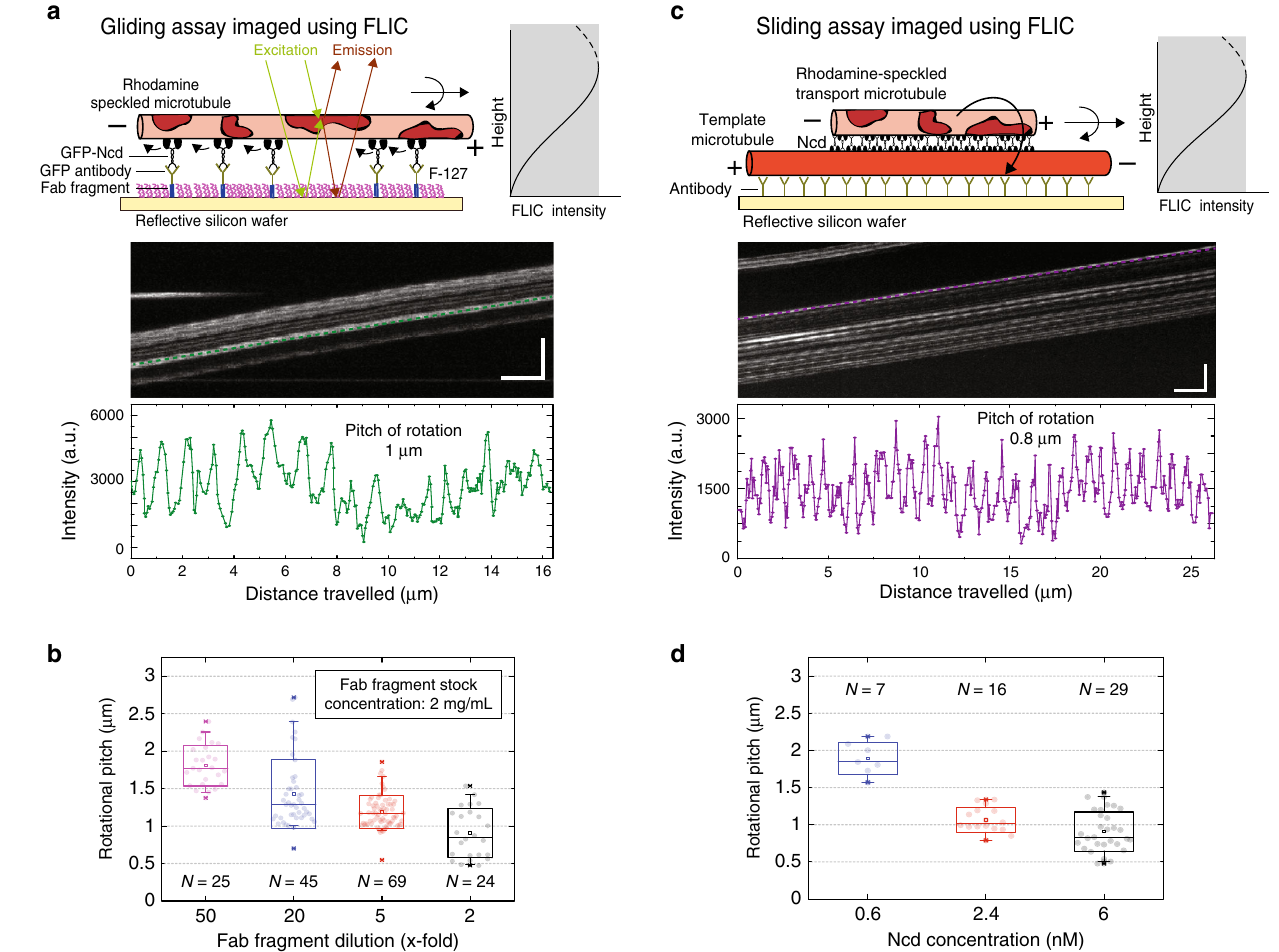
Fig. 4 Dependence of rotational pitch of microtubules on Ncd motor density. a Measurement of the rotational pitch of speckled microtubules gliding on a re fl ective silicon substrate coated with GFP-Ncd via anti-GFP antibodies bound to Fab fragments. Due to fl uorescence interference contrast (FLIC), the recorded intensities of the asymmetric speckles change as a function of height above the substrate. Rotational information of gliding speckled microtubules is interpreted from the periodic variation in the recorded intensity of the speckles on the microtubule (vertical scale bar: 10 μ m; horizontal scale bar: 40 s in the example kymograph, FLIC intensity pro fi le over time for one of the speckles indicated by the green line in the kymograph). The rotational pitch of this gliding microtubule is about 1 μ m. b The rotational pitch of the gliding microtubules was dependent on the surface density of motors. The motor density was set by changing the Fab fragment dilution (Fab fragment stock concentration of 2 mg/mL; diluted 50×, 20×, 5×, and 2×; N = 25, 45, 69, and 24 events, respectively) and ranged between 0.5 and 2.0 μ m. c FLIC-based measurement of the rotational pitch of speckled transport microtubules sliding on surface- immobilized template microtubules (vertical scale bar: 10 μ m; horizontal scale bar: 40 s in the example kymograph, FLIC intensity pro fi le over time for one of the speckles indicated by the purple line in the kymograph). The rotational pitch of this sliding transport microtubule is about 0.8 μ m (see also Supplementary Movie 3). d The rotational pitch of the sliding transport microtubules was dependent on the motor concentration (0.6, 2.4, and 6 nM; N = 7, 16, and 29 events, respectively) and ranged between 0.5 and 2 μ m. All the rotational pitch distributions in ( b ) and ( d ) are signi fi cantly different. Supplementary Fig. 4C provides the corresponding p values obtained from two-sample two-sided Mann – Whitney U -tests. For the boxplot description, see